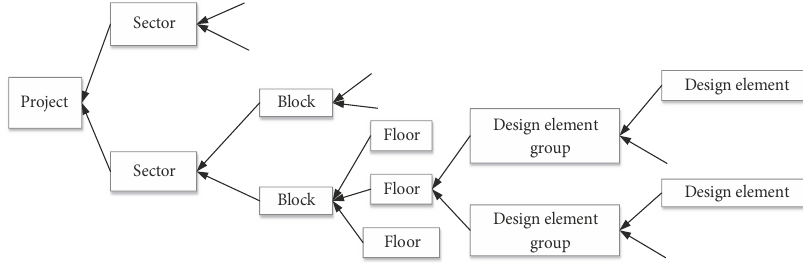
Figure 2. Object hierarchy of product model (Hendrickson et al., 1987)